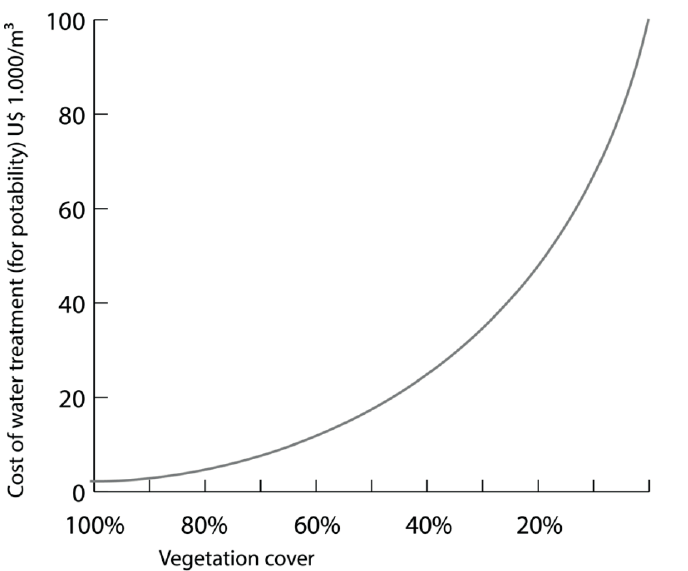
Fig. 2 The cost of water treatment is dependent of the water quality at the source. This is related to soil uses and vegetation cover. Original: J.G.